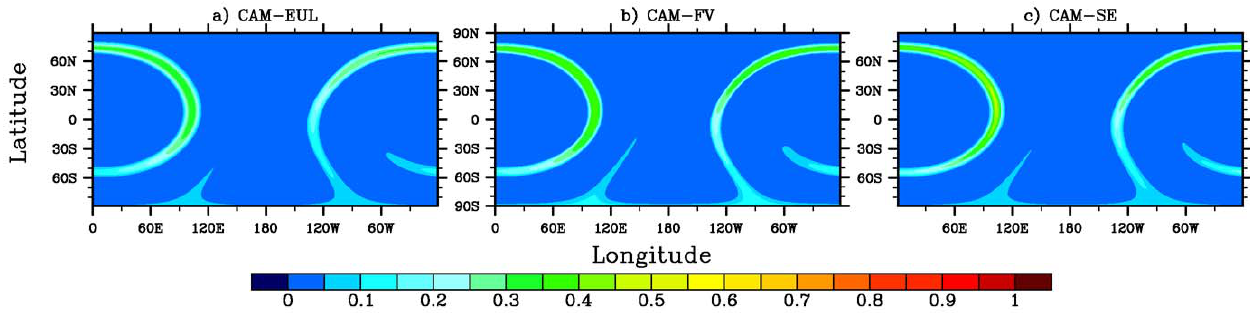
Fig. 8. Tracer mixing ratio results using (a) CAM-EUL, (b) CAM-FV and (c) CAM-SE for test 3 at time t = T . These plots can be compared with the reference solution averaged onto the coarse resolution grid in Fig.